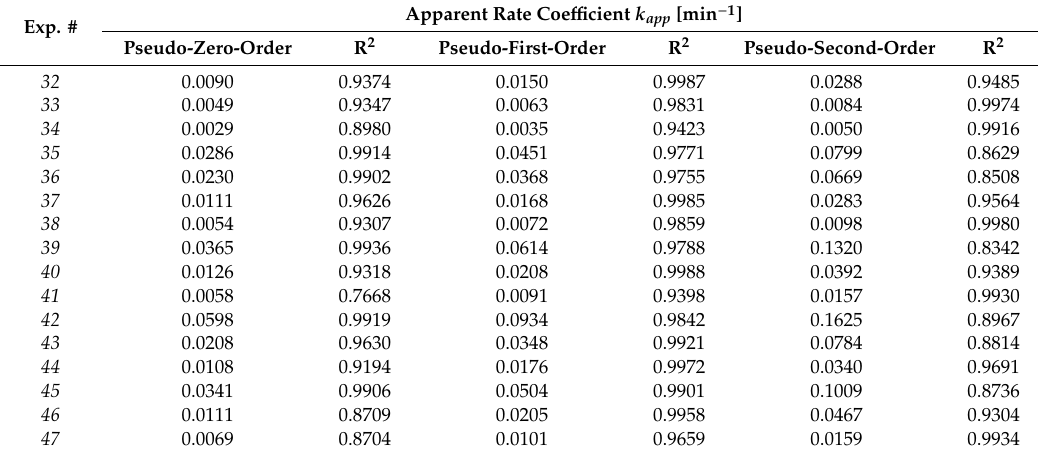
Table A1. Apparent rate coe ffi cients for Equation (A1) at pseudo-zero, -first, and -second-order reaction derived from the NaBr-KBr experimental